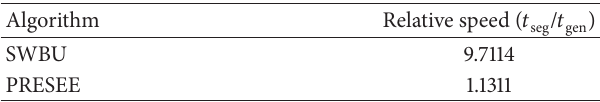
Figure 8: Efficiency of PRESEE for different datasets. Datasets are gathered from different places by ChinaFLUX. Table 3: Relative speed of SWBU and PRESEE compared with data generated by the data